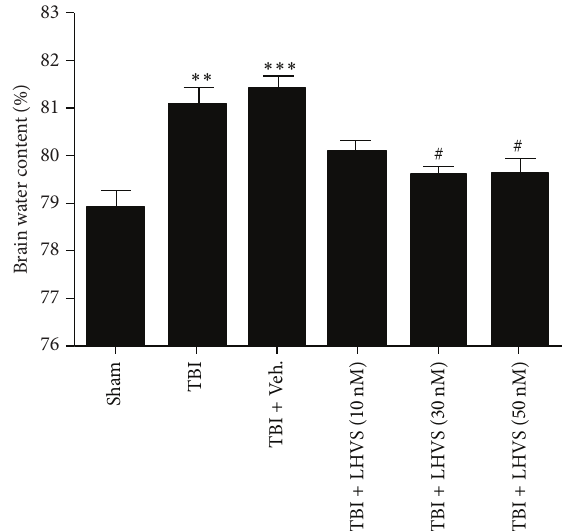
Figure6:LHVSreducescerebraledemaintheipsilateralcortex24 h after traumatic brain injury (TBI). Brain water content was signifi- cantly higher in the TBI and TBI + vehicle groups than in the sham group. Pretreatment with LHVS significantly attenuated brain water contentintheipsilateralcortexcomparedwithvehiclepretreatment. Data are presented as mean ± SEM. ∗∗ 𝑃 < 0.01 , ∗∗∗ 𝑃 < 0.001 versus sham group ( 𝑛 = 5 ); # 𝑃 < 0.05 versus TBI + vehicle